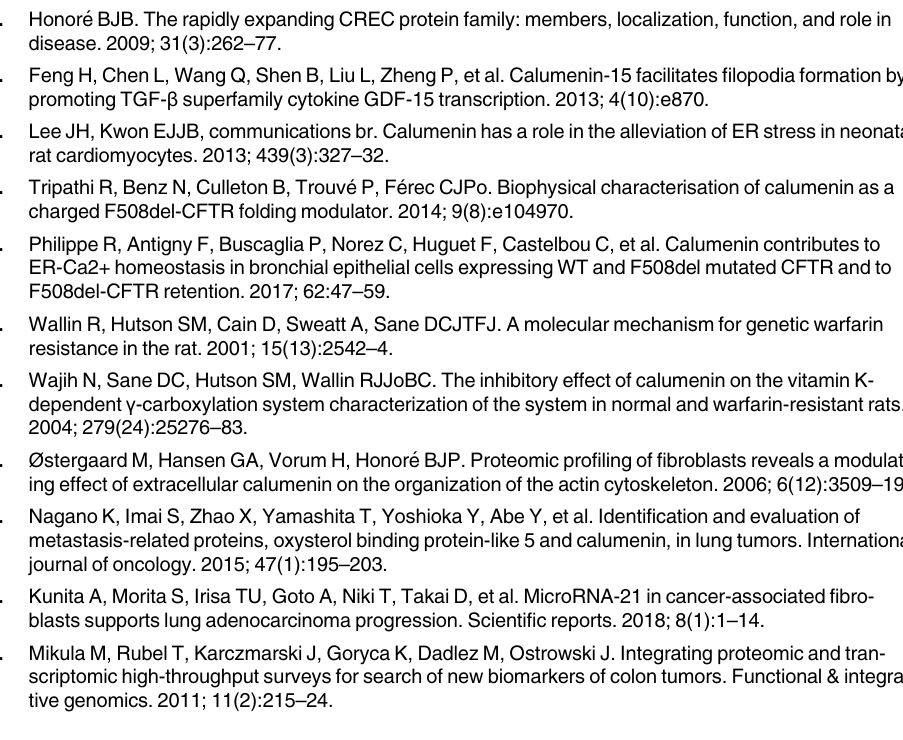
S1 Table. The expression level analysis of upregulated and downregulated genes between tumors and healthy samples in TCGA-COAD (n = 107), and in TCGA-LUAD (n = 87) datasets in the training